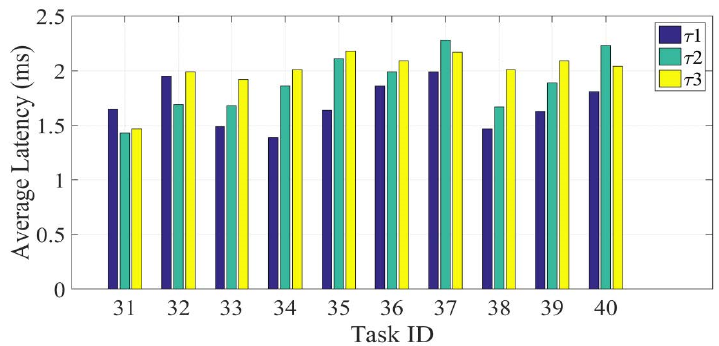
Figure 13. The average latency of handling the fourth group of tasks.